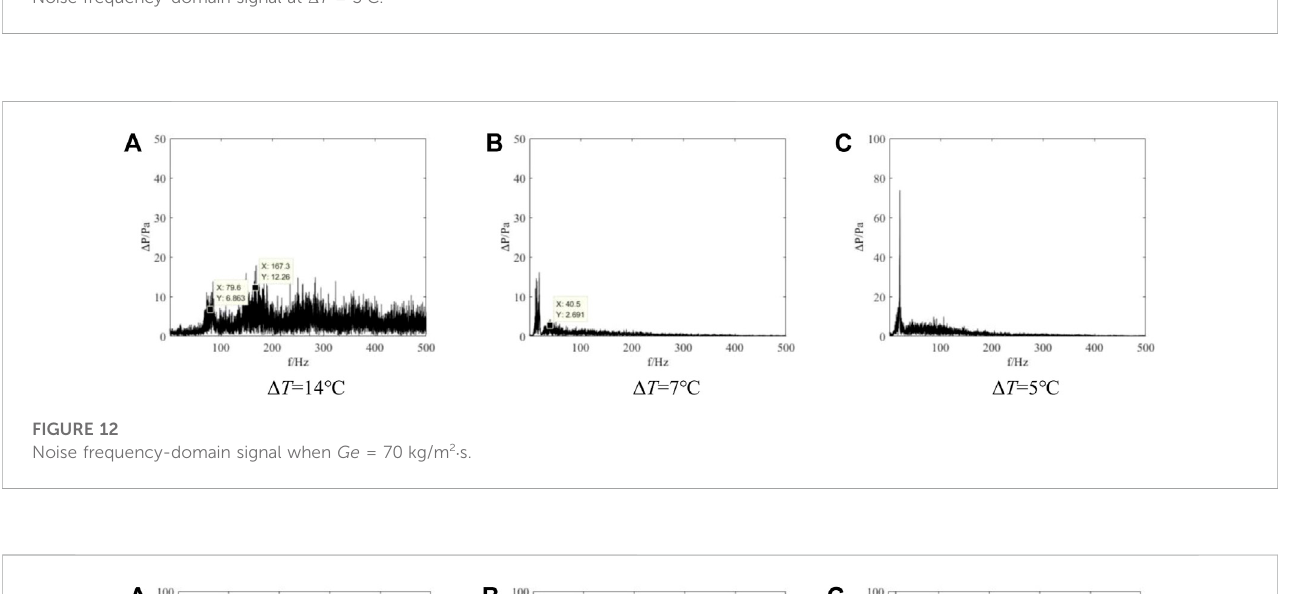
Noise frequency-domain signal at Δ T = 3 ° C.